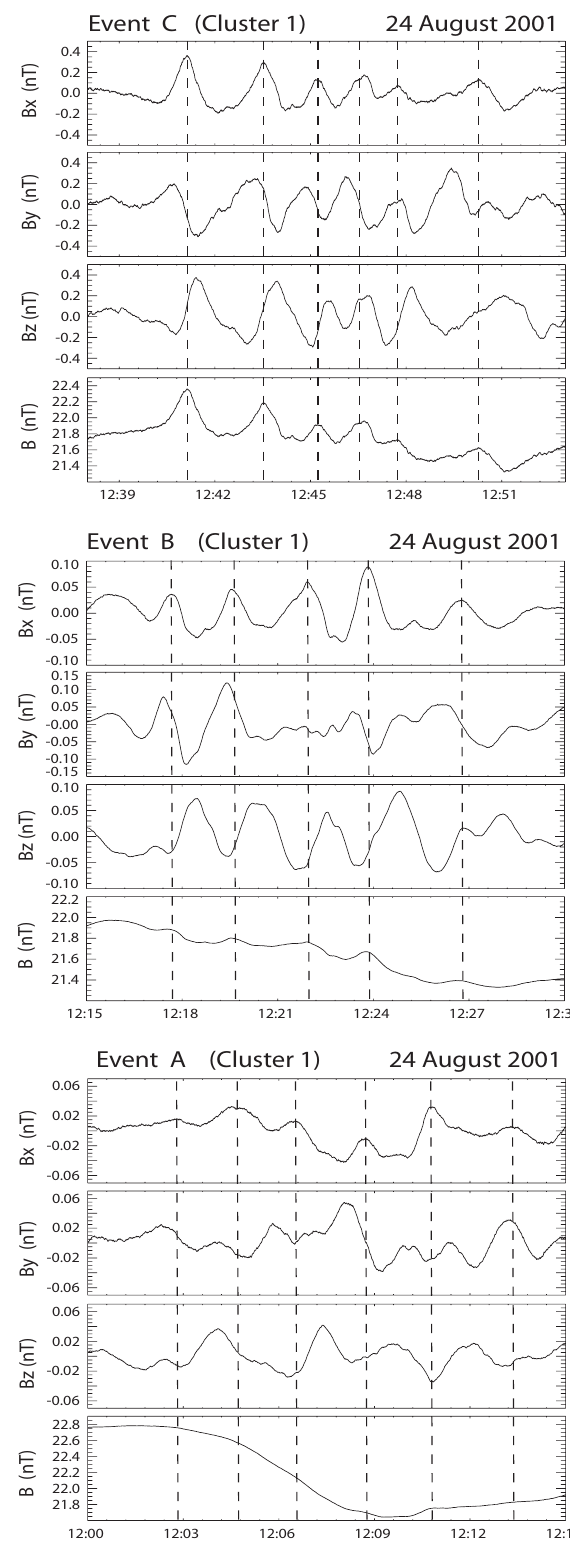
Fig. 3. Magnetic field data for events A, B, and C. The components B x , B y and B z were averaged (40s) and detrended (150s). Vertical dashed lines are visual